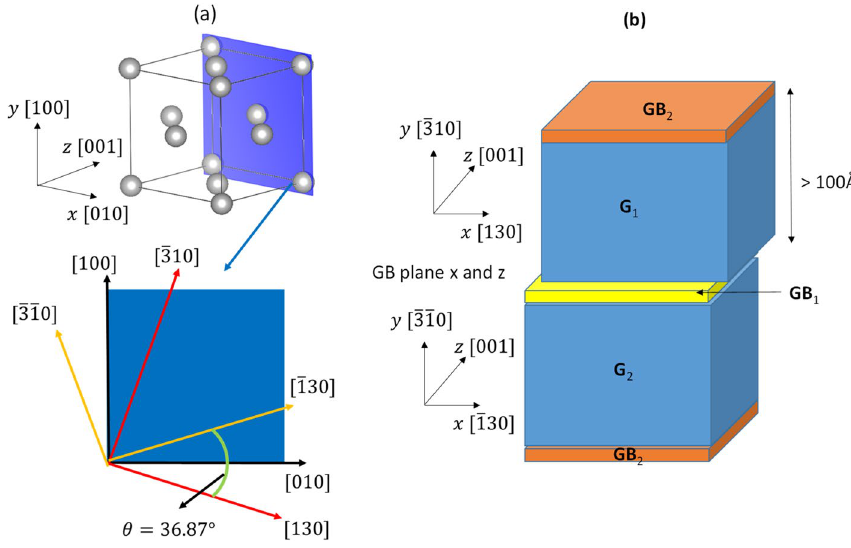
Figure 9. ( a ) GB Σ5-36°87 〈 001 〉 {310} plane for nickel. ( b ) Schematic of a bi-crystal simulation